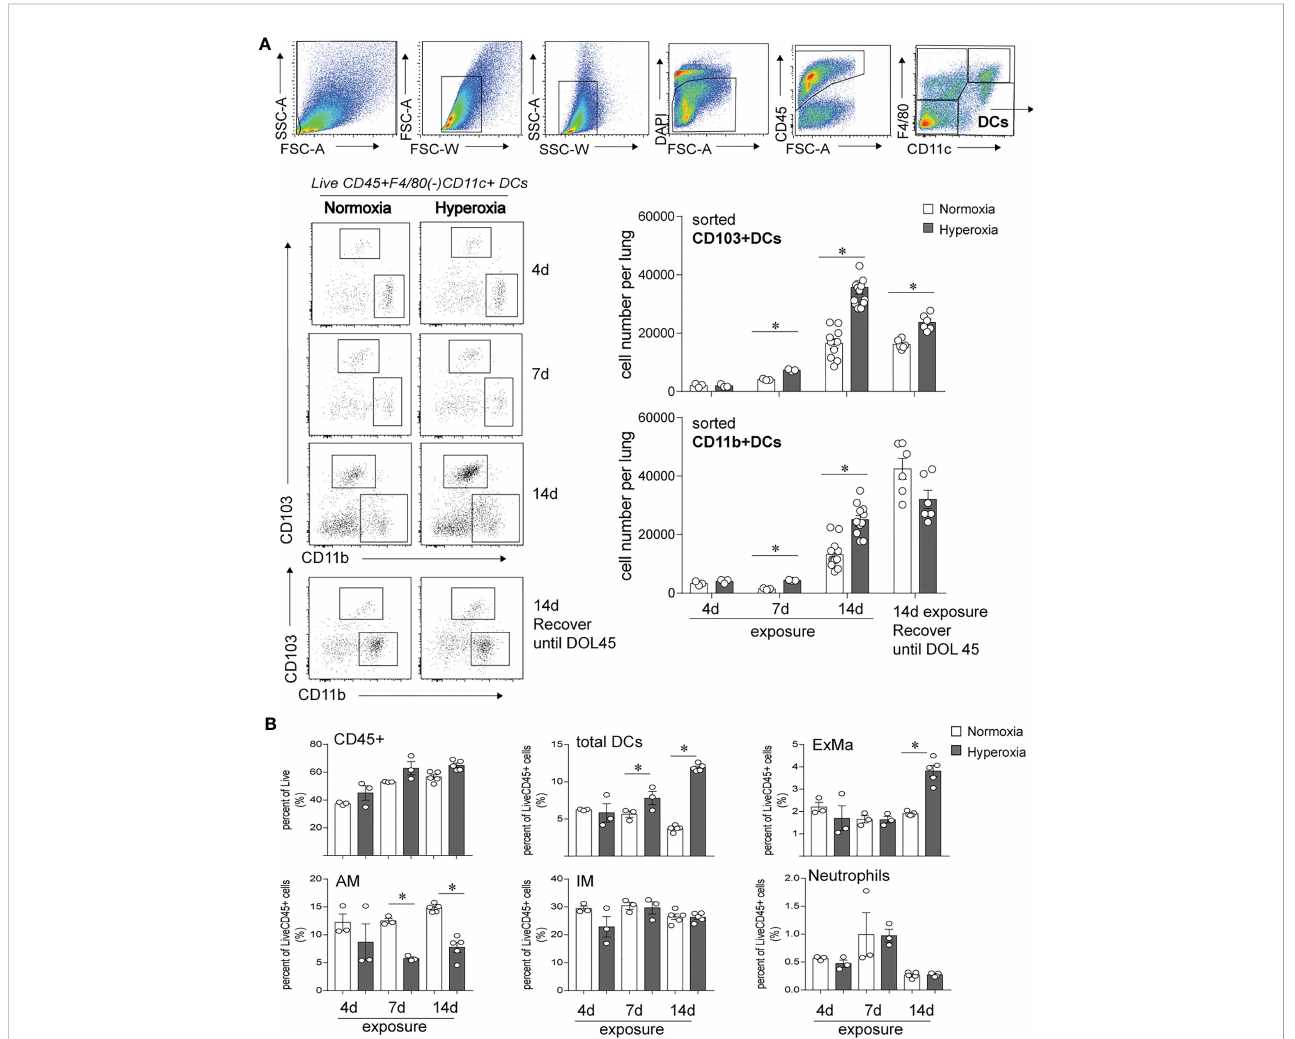
FIGURE 1 Early-life hyperoxic exposure increased the numbers of CD103+ and CD11b hi lung conventional DCs. (A) Two-day-old mice were exposed to normoxia (open bar) or hyperoxia (black bar) for 4, 7 or 14 days (DOL 2 to 16). Lung CD103+ DCs and CD11b hi DCs were determined by fl ow cytometry sorting methods. Sequential fl ow gating scheme is presented. Live dendritic cells (DCs) were de fi ned with surface antibodies DAPI-CD45+F4/80-CD11c+ and further differentiated as CD103+ DC or CD11b hi DC. Cell numbers of CD103+ DC and CD11b hi DCs per lung were quanti fi ed at 4, 7, 14 days of exposure. In some mice, when hyperoxic exposure (DOL 2 to 16) was discontinued, the mice were recovered in room air until adulthood (DOL 45), then lung CD103+ DCs and CD11b hi DCs were analyzed by the similar fl ow sorting and quanti fi cation. (n = 3-12 per group, * P <0.05, one-way ANOVA). (B) CD45+ immune cells, total DCs, Exudative Macrophages (ExMa), Alveolar Macrophages (AM), Interstitial Macrophages (IM), and Neutrophils in lung were also analyzed by fl ow cytometry at day 4, 7 and 14 of the exposure. These results are representative of two independent experiments. * P <0.05 (one-way